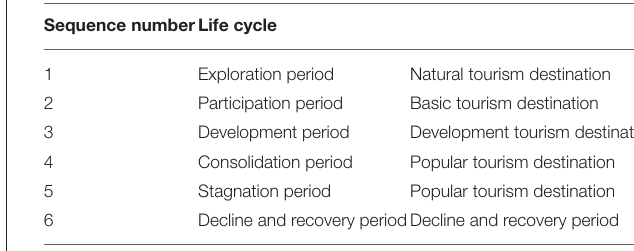
TABLE 3 | Six stages of tourism destination life cycle theory and its